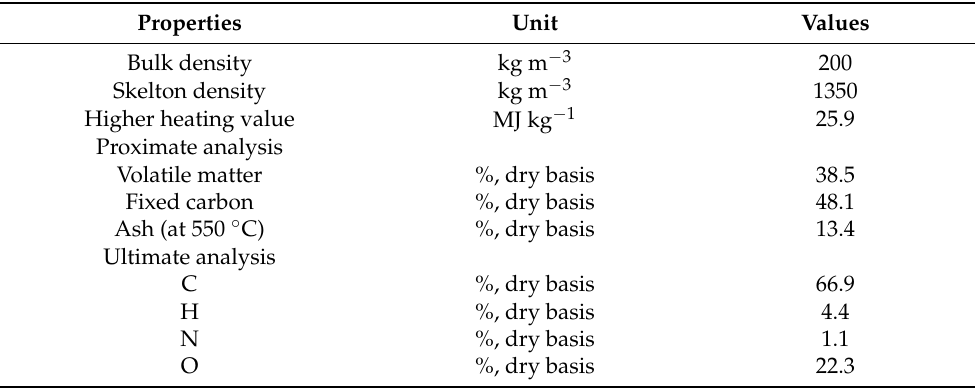
Table 1. Properties of the char